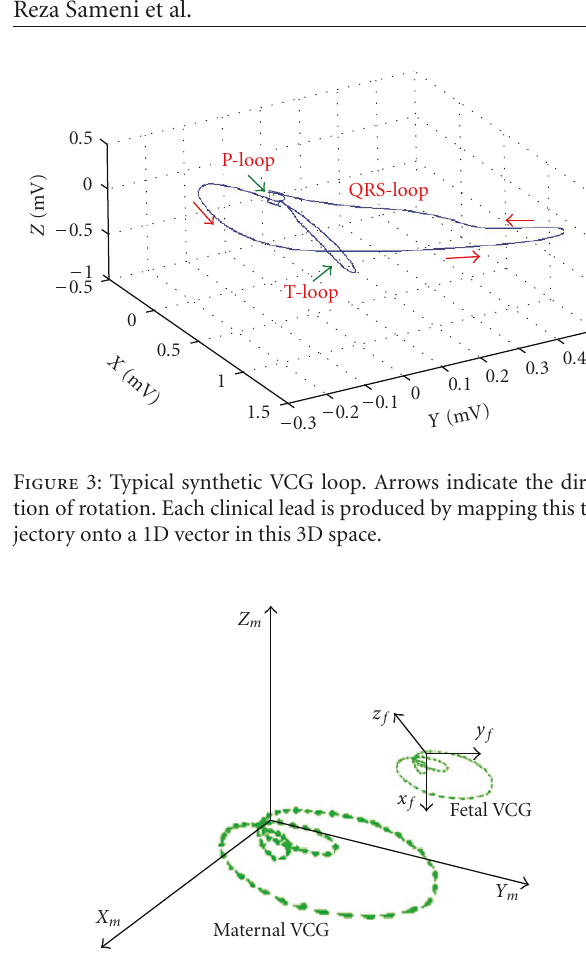
Figure 4: Illustration of the fetal and maternal VCGs versus their body